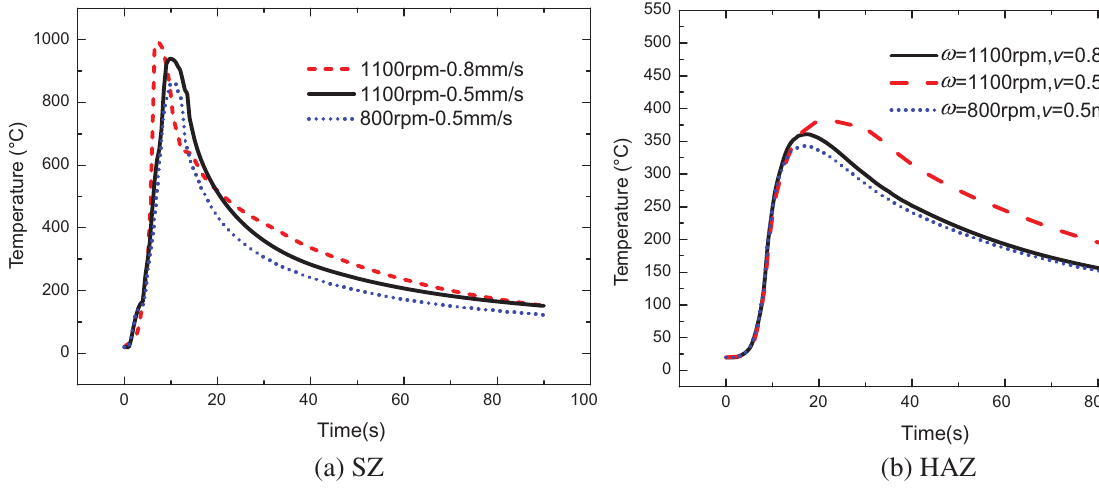
Figure 6: Temperature histories.